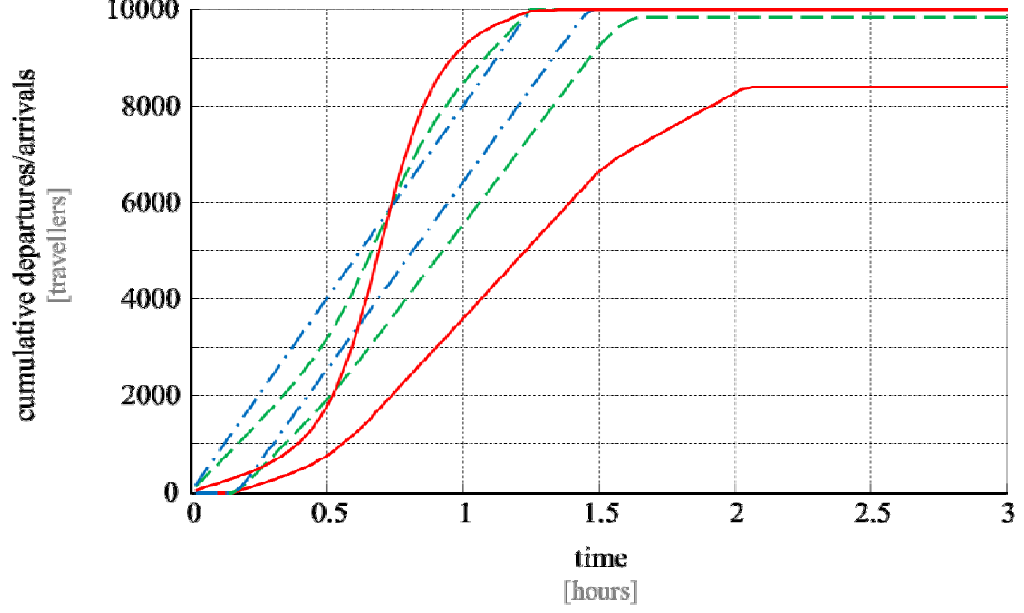
Figure 7. Cumulative departures (upper lines) and arrivals (lower lines): red solid lines, compliance level 2; green dashed lines, compliance level 7; blue dash-dotted lines, compliance level 10 (see Table 1)